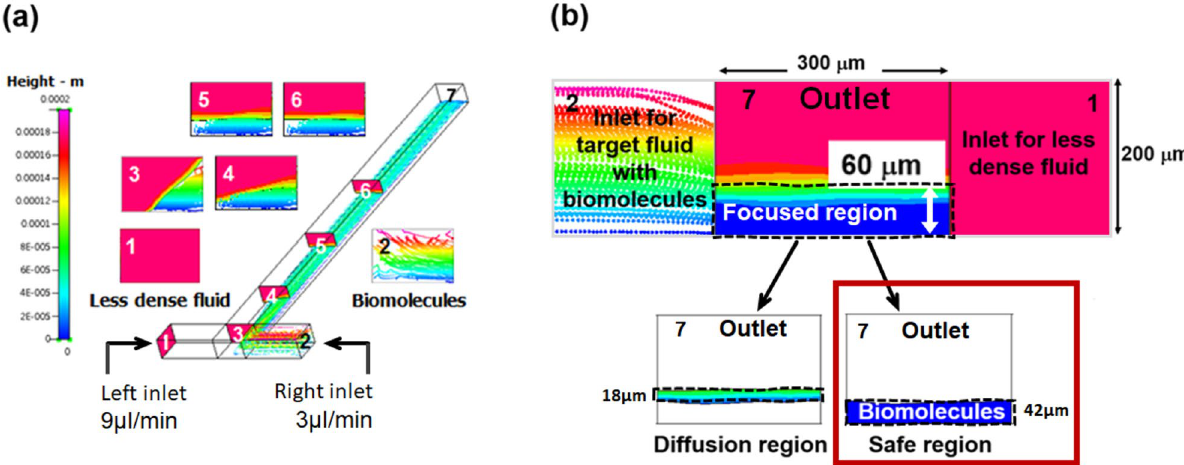
Figure 3. CFD simulation results investigations for; ( a ) the RFF generation by observing target molecule’s behaviors with numbered cross-section views at the left inlet (1), the right inlet (2), the main channel entrance (3), 1 mm (4), 2 mm (5), 3 mm (6), 4.8 mm (7) distant from the entry, ( b ) the denaturation safety analysis of target molecules by ethanol at an outlet of a microchannel (at 7—where the microring sensor is attached) with 60 μm of a focused region, 18 μm of a diffusion region and 42 μm of the safe region thicknesses. The RFF was formed by injecting 3 μL/min of PBS, including polystyrene beads (ball typed dots) as a target fluid and 9 μL/ min of ethanol as a less-dense fluid for the CFD simulation. Both fluids are flowing